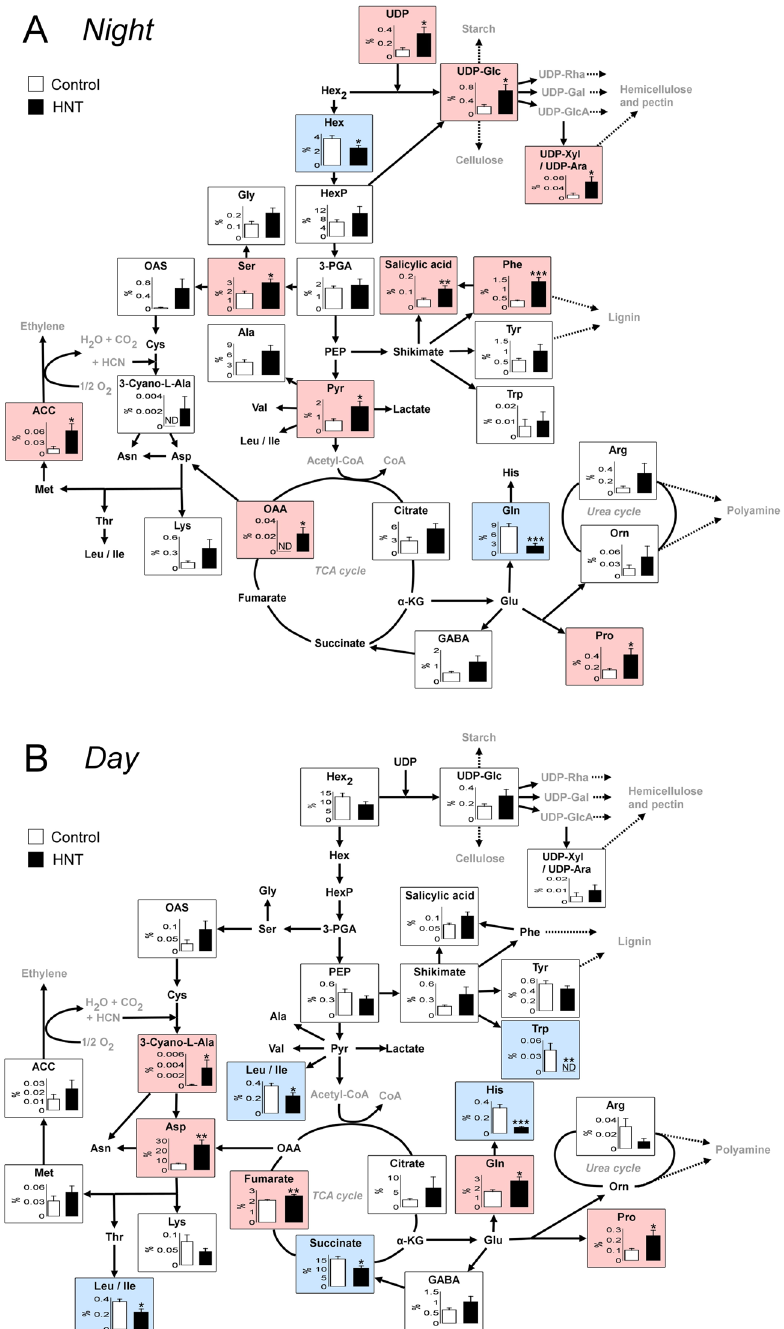
Figure 4. Changes in cell metabolisms in the 9 DAH inner endosperm cells at nighttime ( A ) and daytime ( B ) under HNT conditions. White and black bars indicate control and HNT treatment, respectively. Metabolites highlighted in pink and blue indicate that the relative abundances are significantly higher and lower under HNT treatment, respectively. The data are means ± SE from 9 to 14 kernels from at least three independent plants in each treatment. *, ** and *** show p < 0.05, 0.01 and 0.001 by t- test,